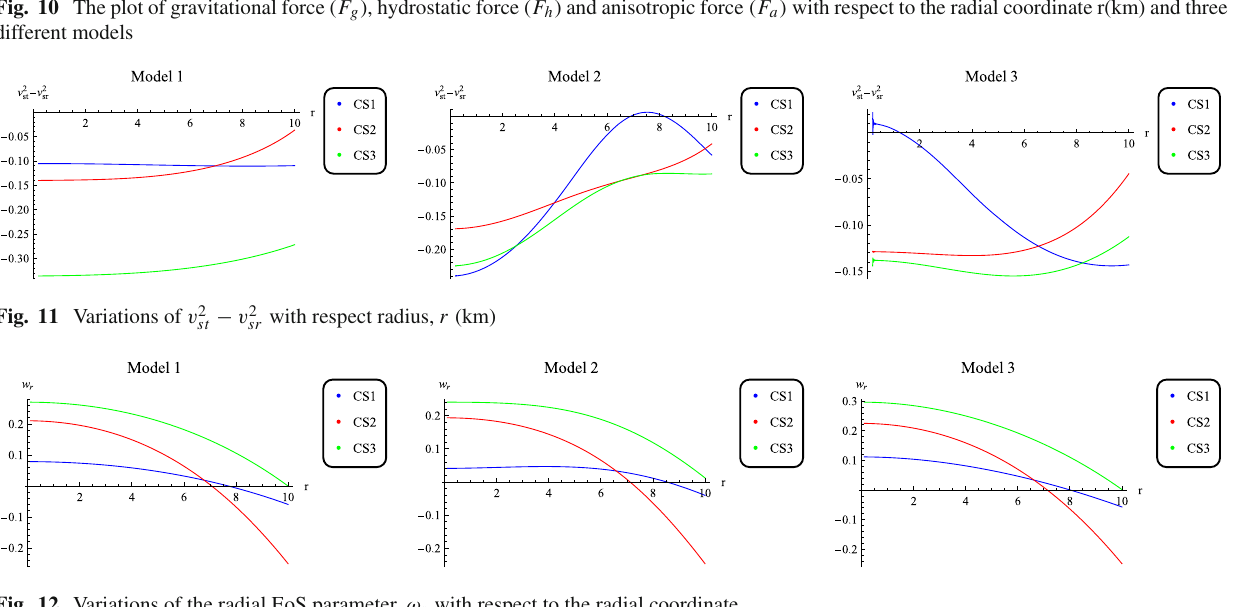
Fig. 12 Variations of the radial EoS parameter, ω r with respect to the radial coordinate − v 2 | < 1 0 < | v 2 st sr